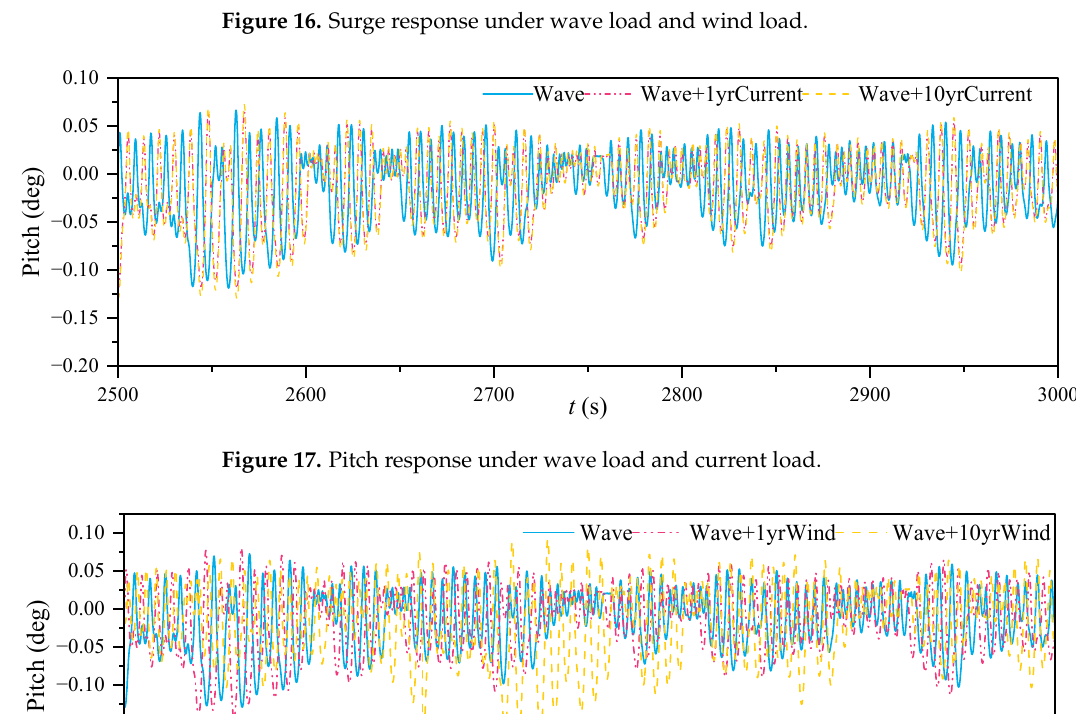
Figure 19. Heave response under wave load and current load.